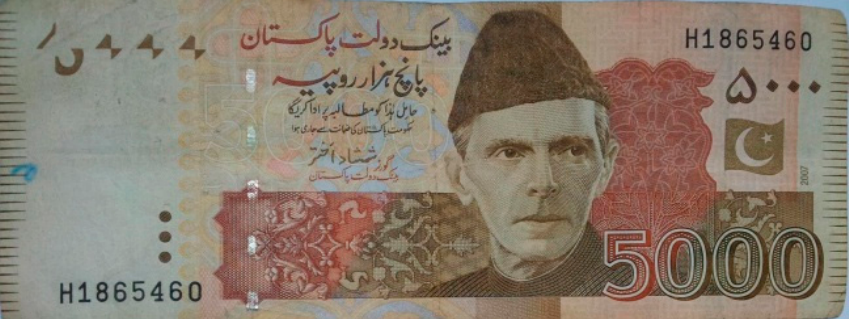
Figure 1. Genuine Banknote.